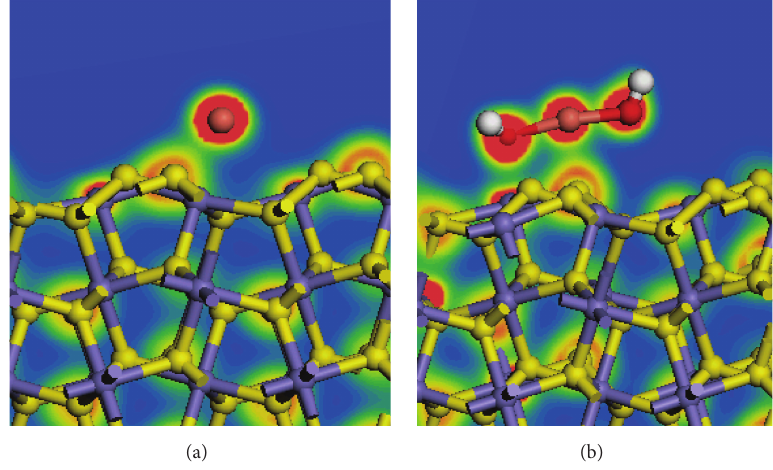
Figure 6: Electron density maps after adsorption of (a) Cu 2+ and (b) Cu(OH) 2